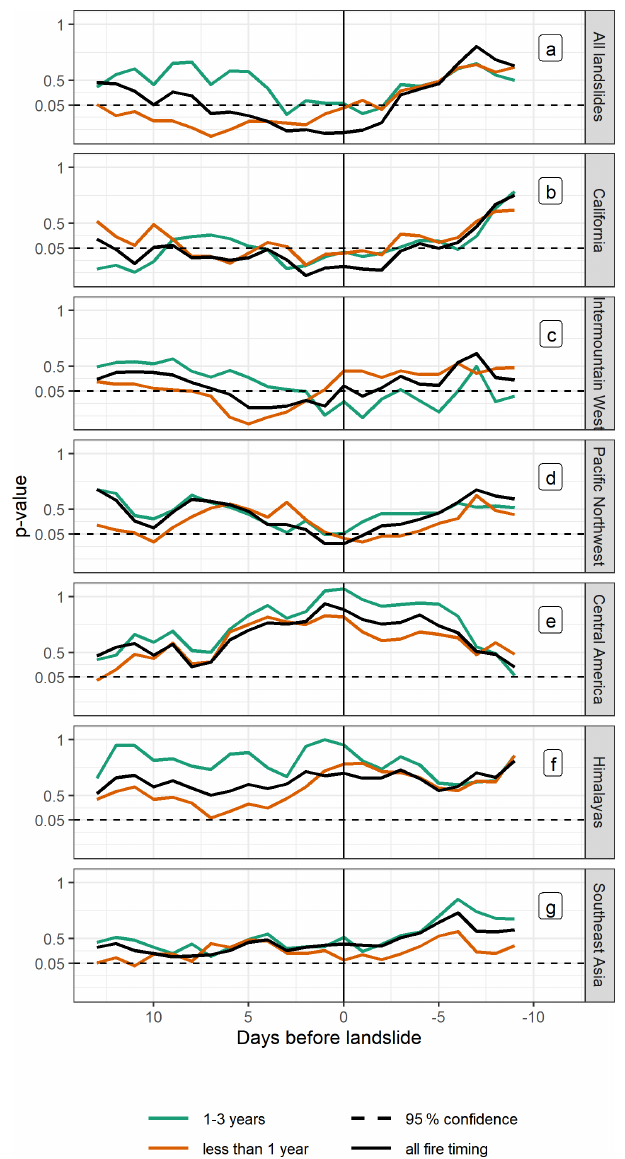
Figure 8. p values for Mann–Whitney hypothesis tests comparing precipitation percentiles at burned and unburned sites. The thick black line shows the p values for all mass movements, while orange and green lines show mass movements occurring within 1 year of a wildfire and between 1 and 3 years of a wildfire, respectively. A hor- izontal dashed black line shows the p = 0 . 05 significance threshold, while a vertical black line indicates the day of the mass